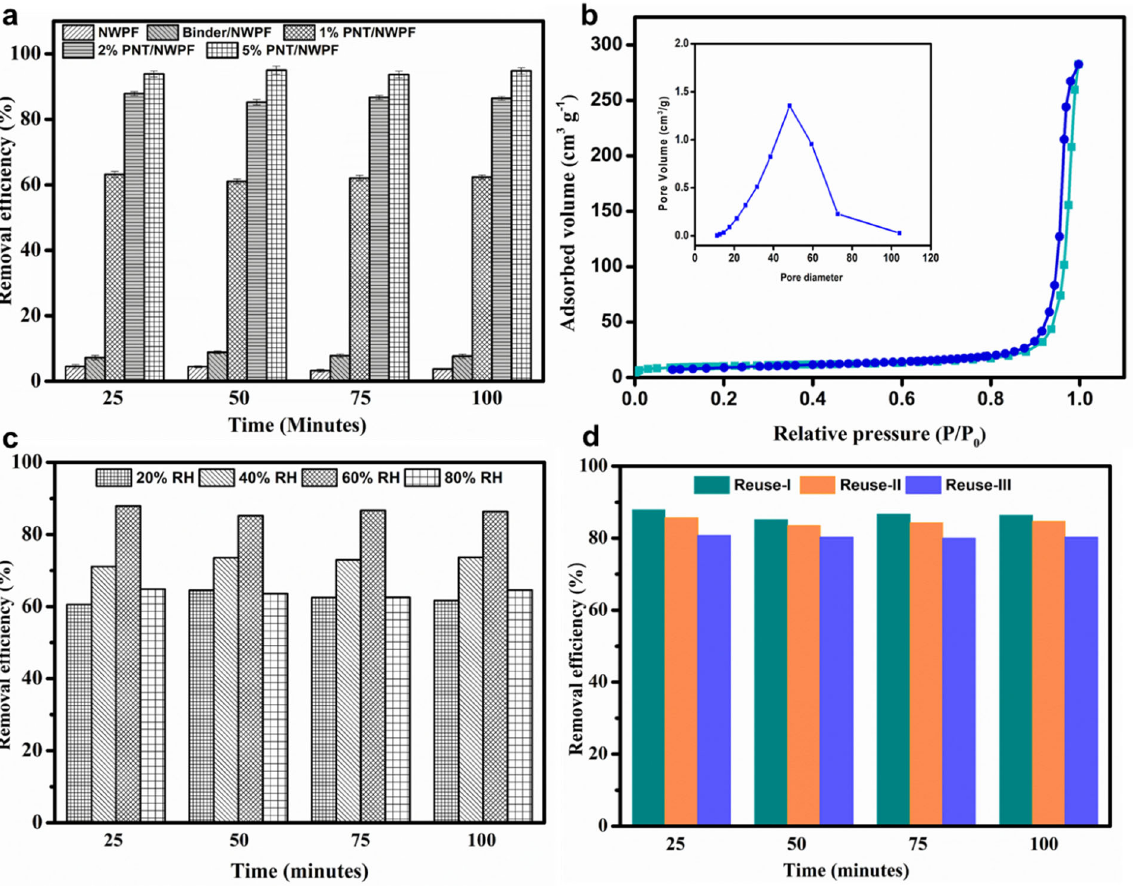
Figure 7. ( a ) VOC removal efficiency of PNT/NWPF for p ‐ xylene destruction. ( b ) N 2 adsorption ‐ desorption isotherm of PNT. ( c ) Effect of relative humidity on PNT/NWPF. ( d ) Reusability of PNT/NWPF.